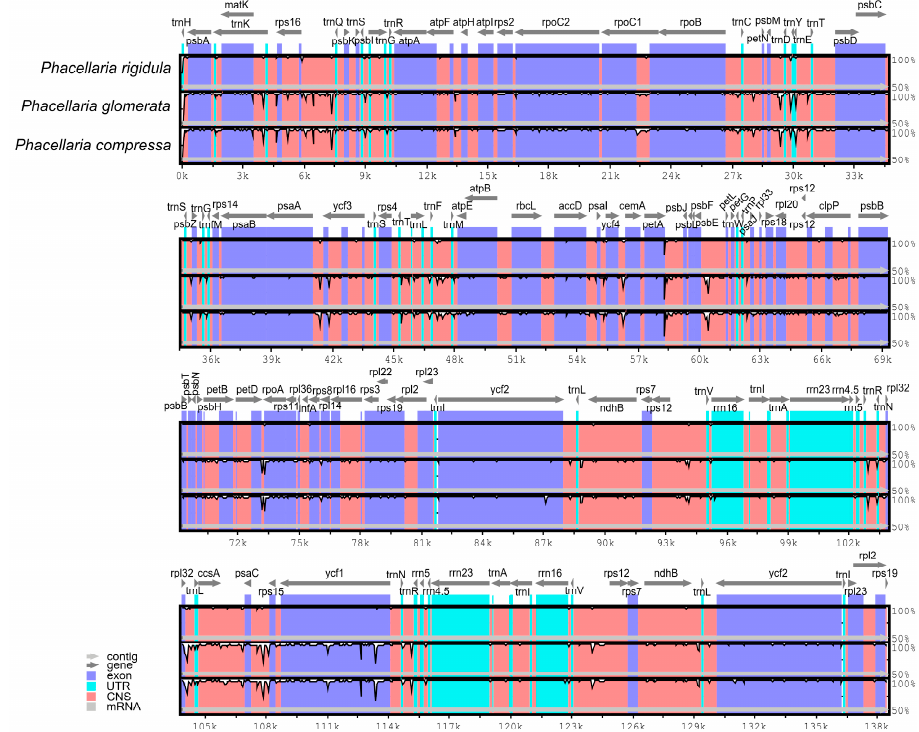
Figure 6. Comparation of chloroplast genomes of 3 Phacellaria species. The x -axis denotes the positions in the chloroplast genome, while the y -axis indicates the average percentage of sequence similarity within the aligned regions, ranging from 50% to 100%.